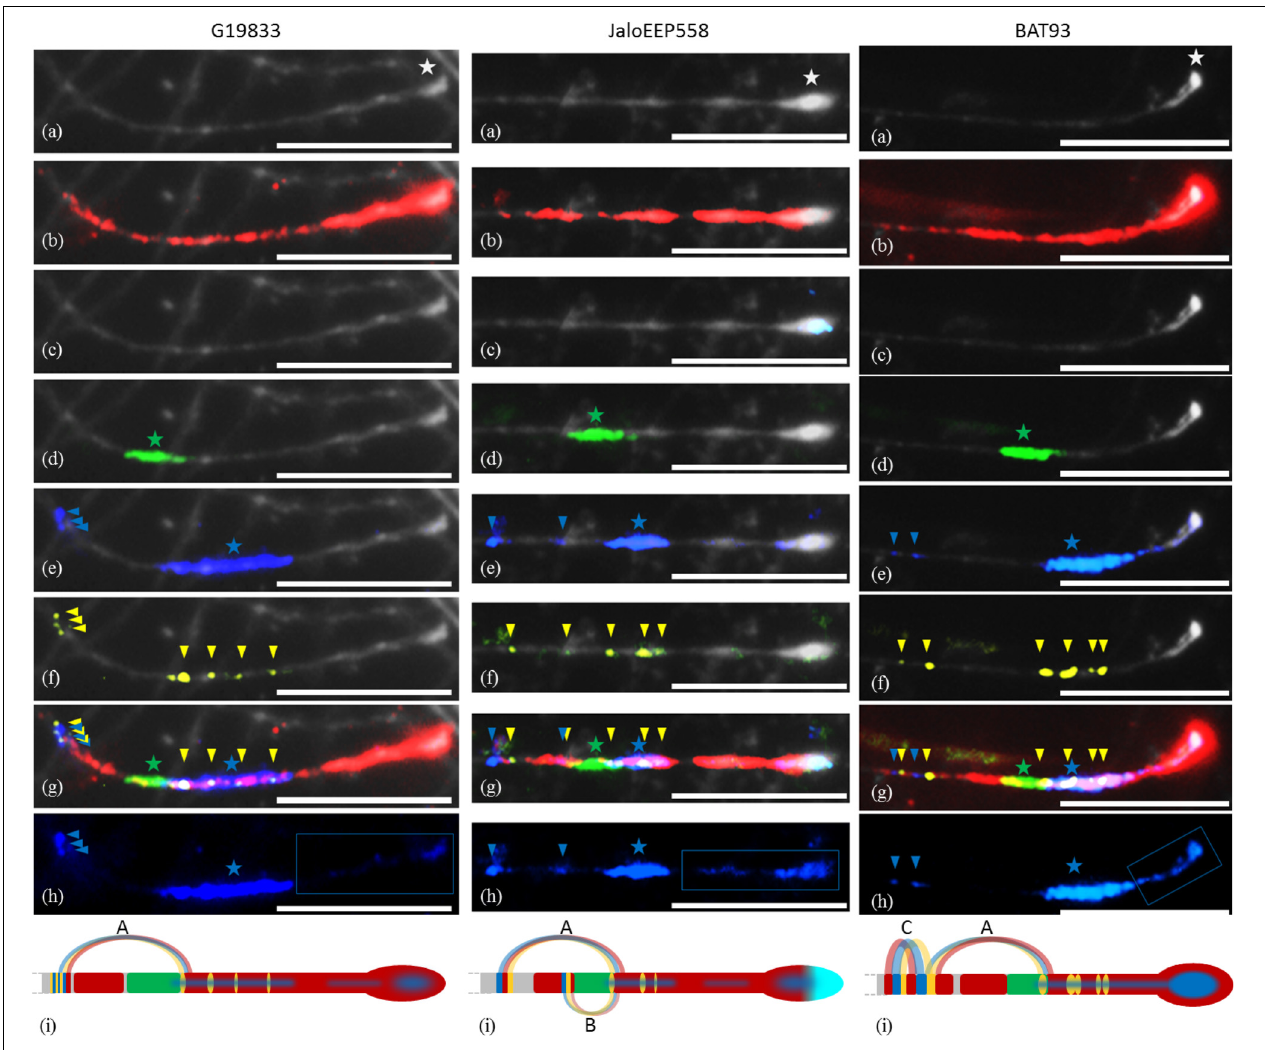
FIGURE 2 | Pachytene FISH mapping of multiple probes at the end of chromosome 11 in common bean genotypes G19833 and JaloEEP558 (Andean) and BAT93 (Mesoamerican). These experiments were done at least twice for each genotype with similar results, except for G19833 because it was highly difficult to obtain buds containing cells at the pachytene stage from this genotype. The number of loci for each probe was confirmed in at least three cells per experiment. Bars = 10 µ m. (a) Black-white-converted image showing the end of chromosome 11 stained with DAPI. Terminal knob is indicated by a white star. (b) khipu satellite (red). (c) 45S rDNA (light blue). For G19833, cells were too much damaged for analyzing 45S rDNA. (d) FISH-CNL1 probe (green). The large CNL1 signal corresponding to the Co-2 cluster is indicated by a green star. (e) FISH-CNL3/4 probe (blue). The large CNL3/4 signal corresponding to the Co-2 cluster is indicated by a blue star. Additional CNL3/4 loci are indicated by blue arrowheads. (f) FISH-TNL-7 probe (yellow). Loci are indicated by yellow arrowheads. (g) Overview of FISH-CNL1 (green), FISH-CNL3/4 (blue), FISH-TNL-7 (yellow), khipu (red) and 45S rDNA (light blue). The main CNL1 and CNL3/4 clusters (corresponding to region sequenced in Figure 1 ) are indicated by a green star and a blue star, respectively. Additional CNL3/4 and TNL-7 loci are indicated by blue and yellow arrowheads, respectively. (h) FISH-CNL3/4 probe without DAPI counterstaining. The terminal FISH-CNL3/4 signals are boxed. The main CNL3/4 cluster is indicated by a blue star. Additional CNL3/4 loci are indicated by blue arrowheads. (i) Diagrammatic representation of cytogenetic maps of chromosome 11 long arm terminal region, and hypothetical model of evolution. Chromosomes are in gray, and colors are the same as described above. Curved lines represent minimal putative ectopic segmental duplications involving TNL-7 (yellow), CNL3/4 (blue), and khipu